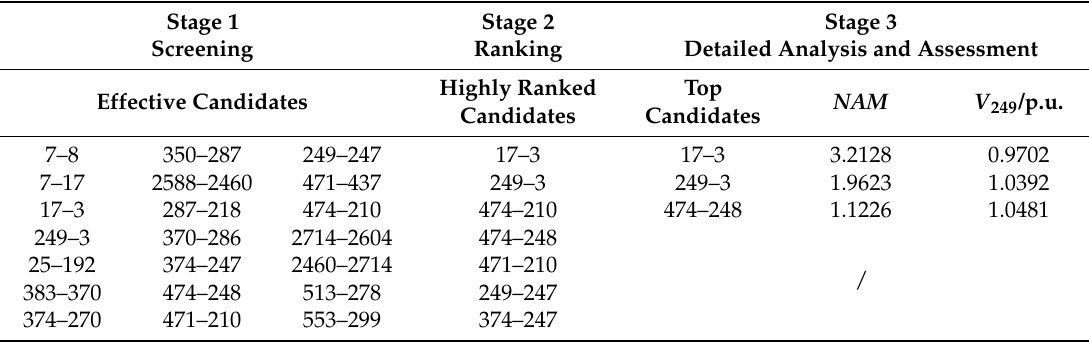
Table 5. Result of lines switched